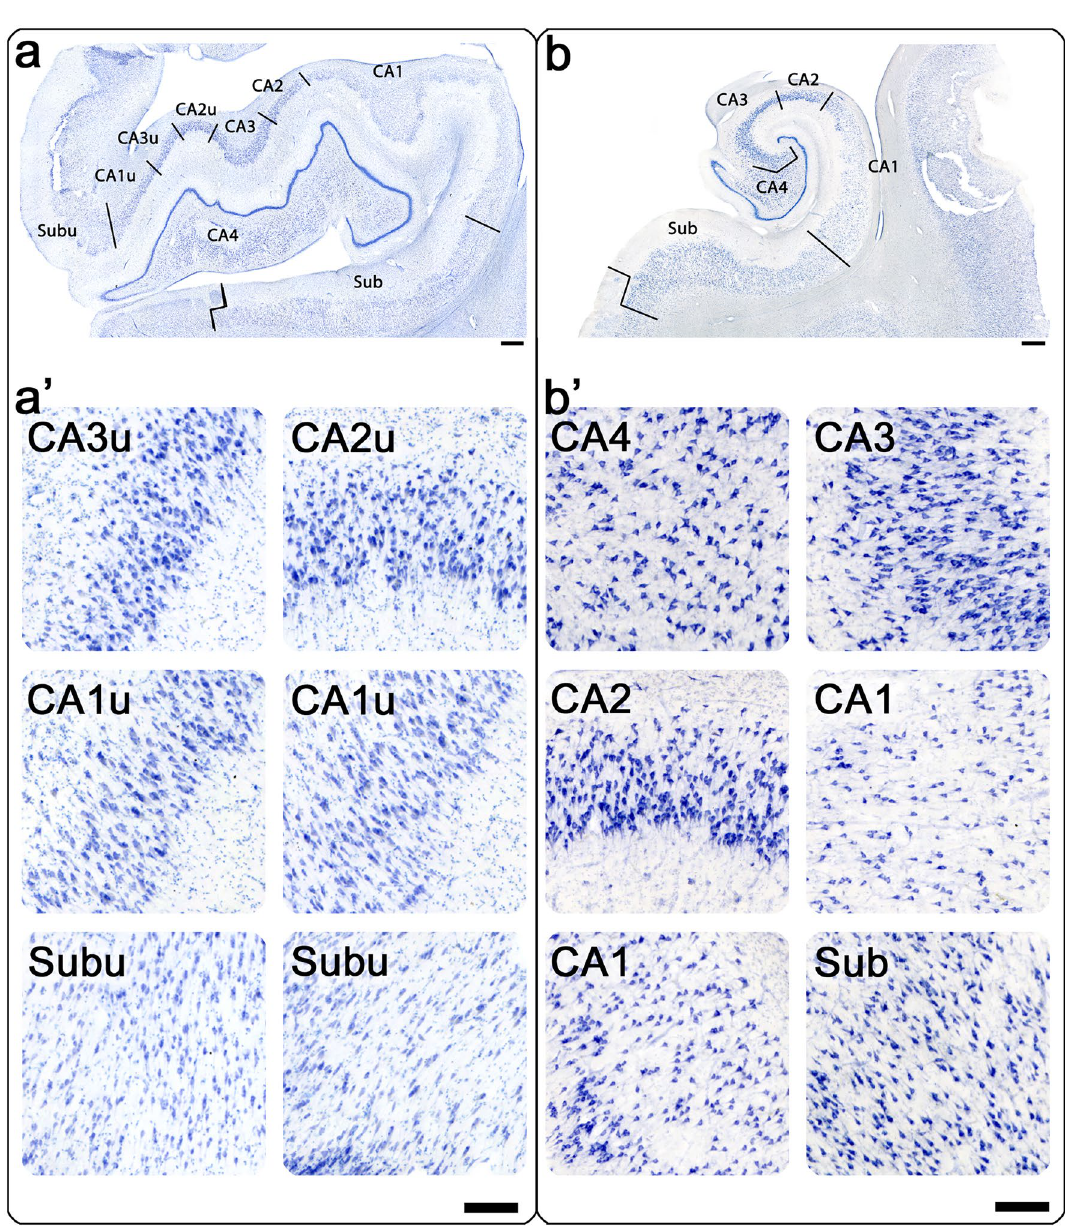
Figure 1. Cytoarchitecture characteristics of hippocampal subregions in Nissl staining: ( a ) medial (uncal) hippocampal subregions at the level of the hippocampal head: CA3u, CA2u, CA1u, Subu. ( a’ ) Pyramidal layers of the medial hippocampal subregions. ( b ) Lateral hippocampal subregions at the level of the hippocampal body, clockwise: CA4, CA3, CA2, CA1, Sub (subiculum). ( b’ ) Pyramidal layers of the lateral hippocampal subregions. Magnification bars in ( a, b ) = 1 mm; in ( a’,b’ ) = 200